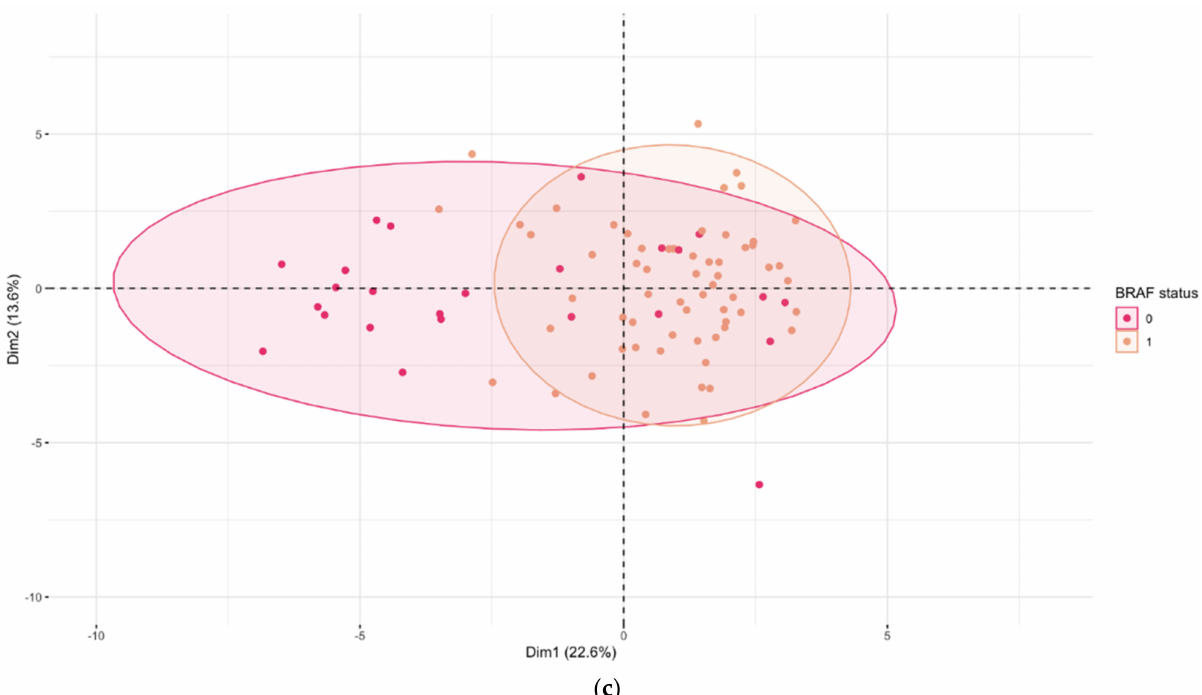
Figure 3. ( a ) Samples colored according to the disease; ( b ) samples colored according to the HCL score; ( c ) samples colored according to the BRAF mutational status. Component principal analysis (CPA) projection (first versus second principal component). Each dot corresponds to a sample (cHCL n = 64, cHCL BRAFWT n = 8, vHCL/SDRPL n = 5, HCL-like NOS n = 9). Variables used: (percentage of expression + median of fluorescence of CD19, CD20, CD79b, FMC7, CD5, CD10, CD23, CD43, CD38, CD11c, CD103, CD123, CD25; percentage of abnormal cells on sample, percentage of abnormal cells compared to total lymphocytes). Variables factor map in the right corner. Ellipses represent confidence level for a concentration of 90%. Analysis of blood cell count is useful for HCL classification. When adding the blood cell count (absolute lymphocyte count (ALC), absolute monocyte count (AMC), absolute neutrophil count (ANC), platelet count (PC), hemoglobin (Hb), CD4/CD8 T cell ratio and CD26 expression data, PCA achieved good discrimination between classical HCL and HCL-like disorders without overlap (Figure